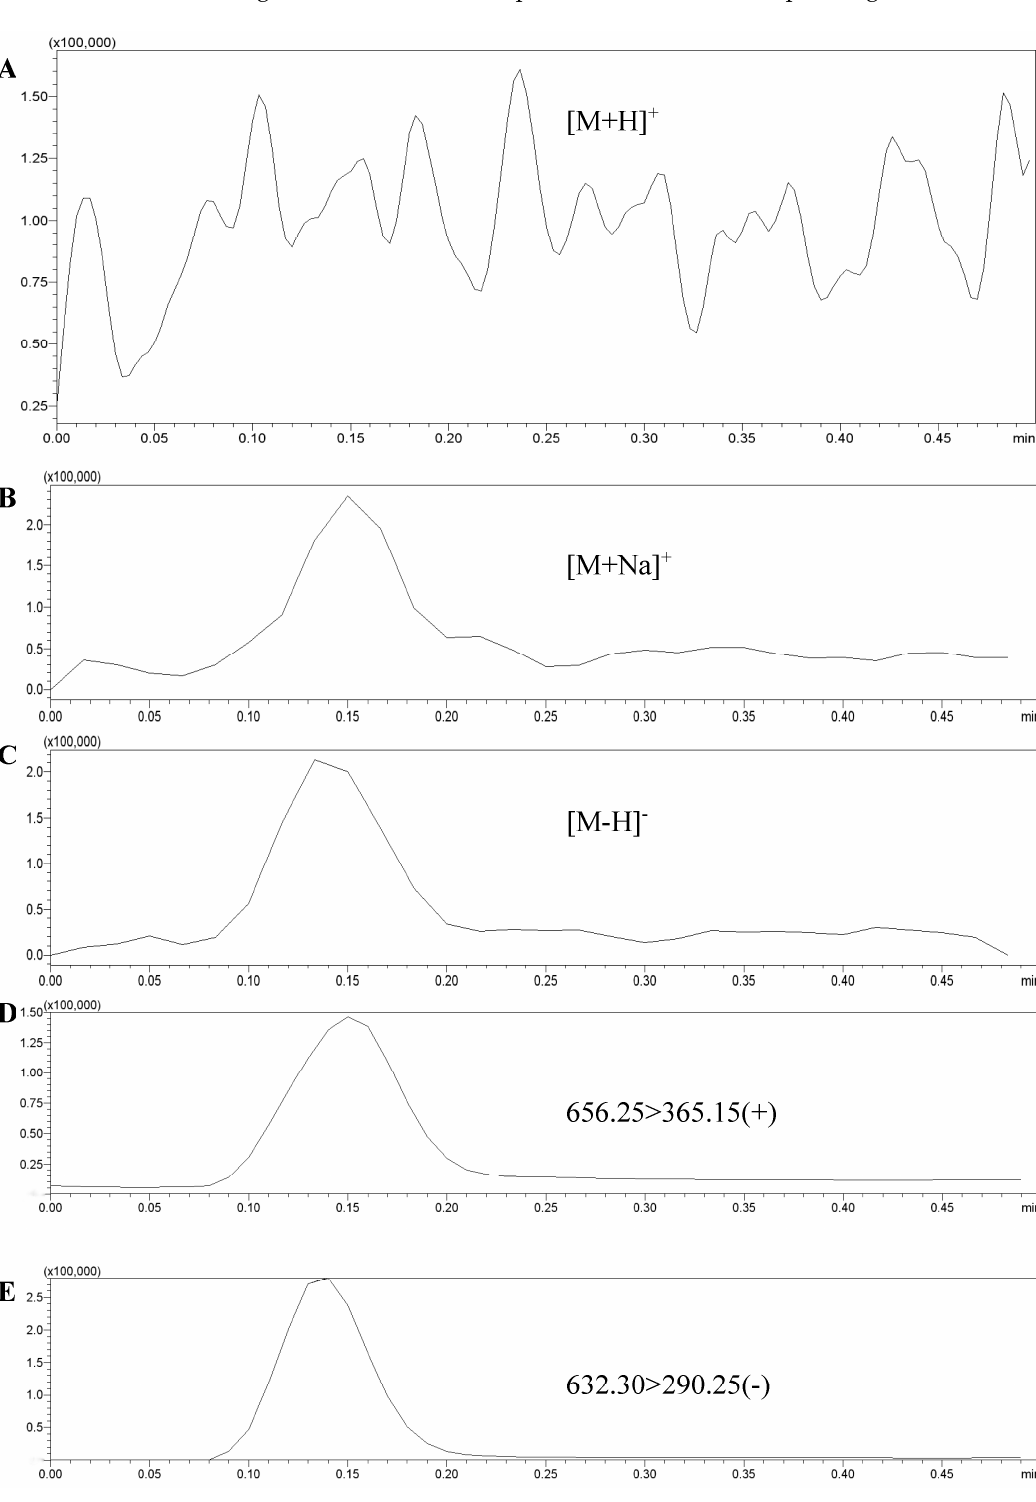
Figure 1. The responses of [M + Na] + and [M − H] − molecular ion peaks and fragment ion peaks. ( A ): [M + H] + molecular ion peaks; ( B ): [M + Na] + molecular ion peak; ( C ): [M − H] − molecular ion peak; ( D ): [M + Na] + fragment ion peak; ( E ): [M − H] − fragment ion peak.